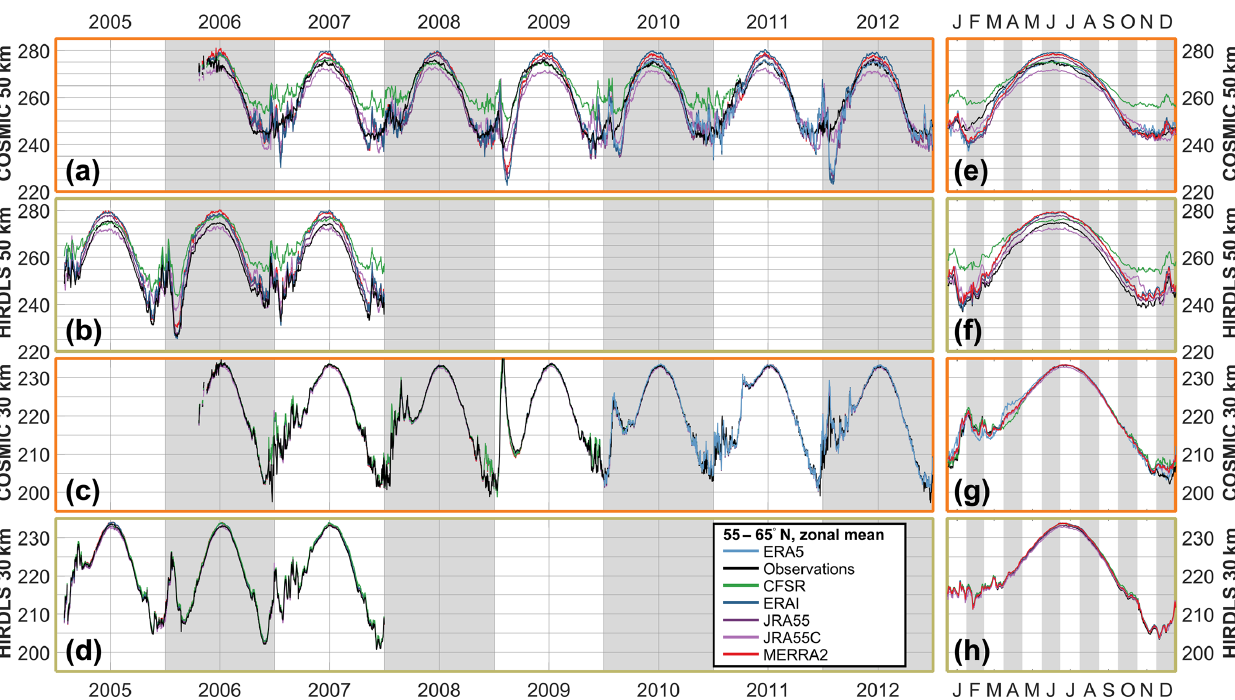
Figure 8. Time series of observed and sampled-reanalysis temperature, averaged over 55–65 ◦ N, at (a, b, e, f) 50km and (c, d, g, h) 30km in altitude. Panels (a) – (d) show time series over the period 2003–2012, and panels (e) – (h) the annual cycle derived from the extended time